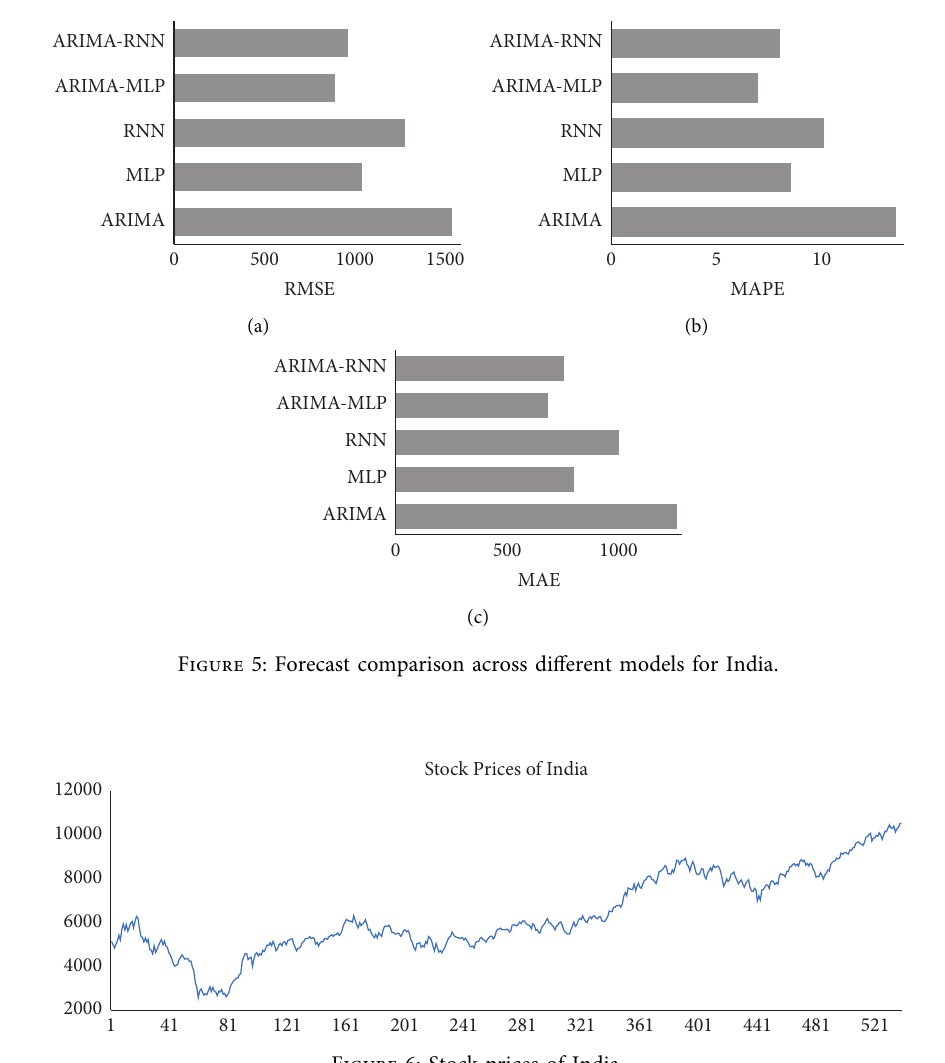
Figure 6: Stock prices of